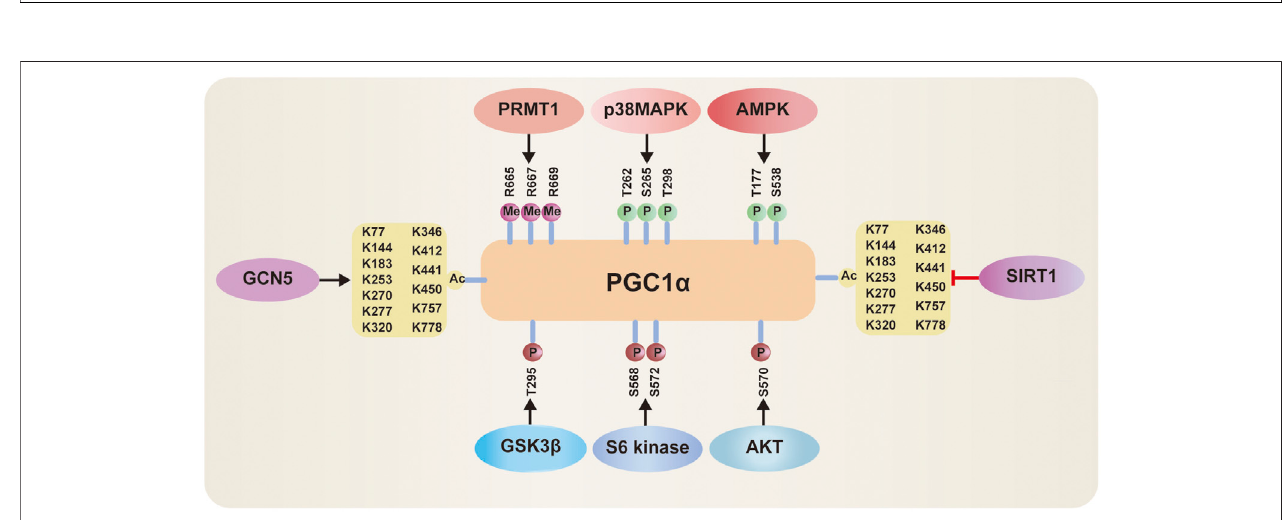
FIGURE 4 | Posttranslational modi fi cations of PGC-1 α : 1) PGC-1 α activity can be activated via methylation by protein arginine methyltransferase1 (PRMT1), phosphorylated by p38 mitogen-activated protein kinase (MAPK) and AMP-activated protein kinase (AMPK), deacetylation by Sirtuin-1 (SIRT1). 2) PGC-1 α activity can be inhibited via acetylation by general control of amino acid synthesis 5 (GCN5), phosphorylation by Akt, S6 Kinase, or glycogen synthase kinase 3 β (GSK3 β ).